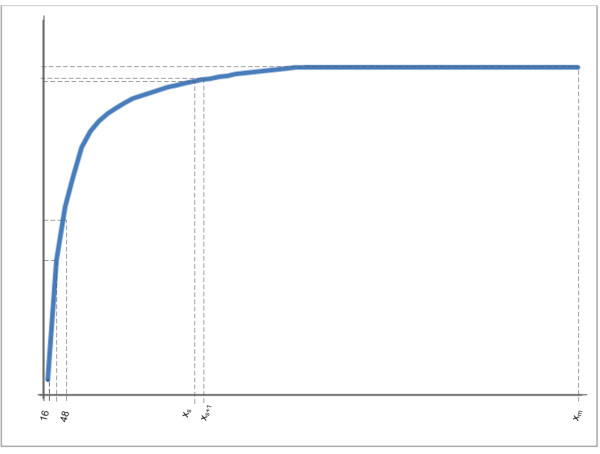
Generic learning curve.